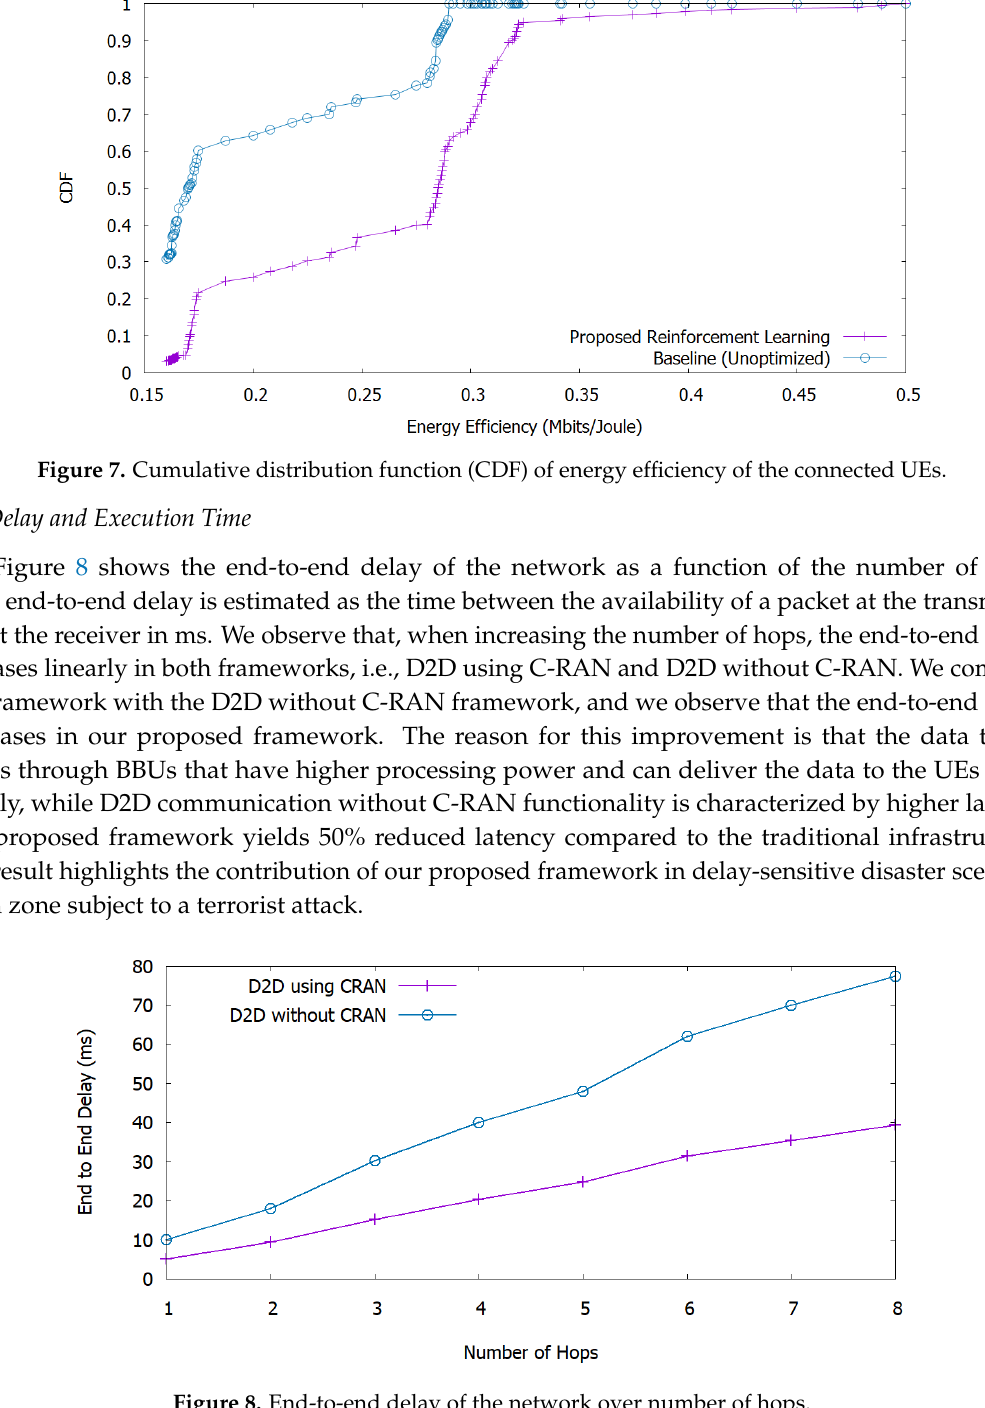
Figure 8. End-to-end delay of the network over number of